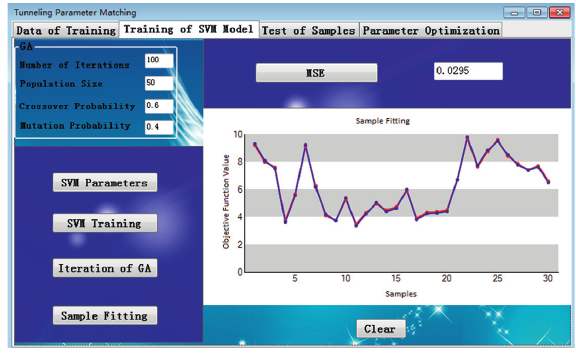
Figure 4: The interface of the SVM model training.